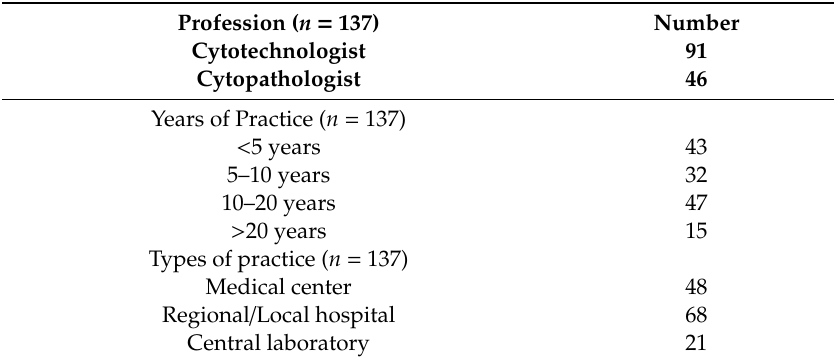
Table 1. Summary of the Participants’